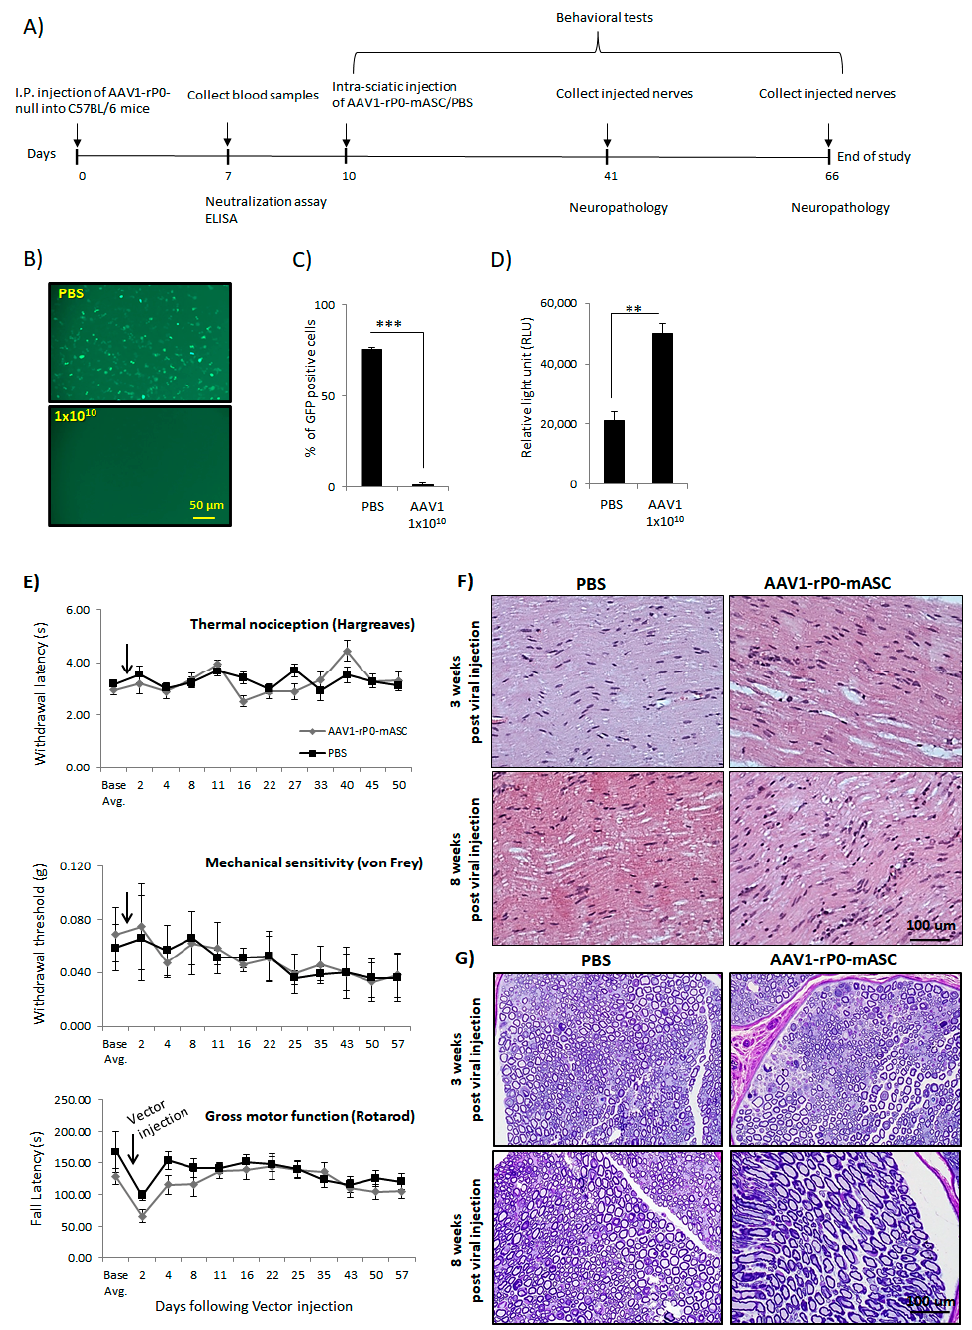
Figure 5. Preexisting AAV1 immunity does not affect safety of intrasciatic AAV1-rP0-mASC in C57BL/6 mice. ( A ) Schematic diagram for the experimental design. ( B ) AAV-rP0-null (1 × 10 10 gc) or PBS was injected I.P. into immunocompetent C57BL/6 mice and blood sera were collected 1 week post injection. Dilutions of the collected sera were mixed with AAV1-CBA-GFP, added to HeLa cells, and two days later GFP expression were monitored. ( C ) Quantification of the GFP positive cells showed that AAV1-rP0-null injection resulted in reduced GFP expression compared to the sera collected from PBS-injected mice. ( D ) ELISA for AAV1 antibodies showed AAV1-rP0-null injected mice had more anti-AAV1-antibody than PBS-injected animals. One-way ANOVA was utilized for statistical analysis. Results are represented as the mean ± SEM; n = 3 mice per group. ** p < 0.01, *** p < 0.001. ( E ) Effect of intrasciatic AAV1-rP0-mASC or PBS injection on pain behaviors, thermal nociception (Hargreaves test, top ) and mechanical sensitivity (von Frey method, middle ), and on gross motor function (rotarod, bottom ) was evaluated at 2- to 7-day intervals for approximately 7 weeks following vector/PBS injection. Arrows show time of vector/PBS injection. Repeated